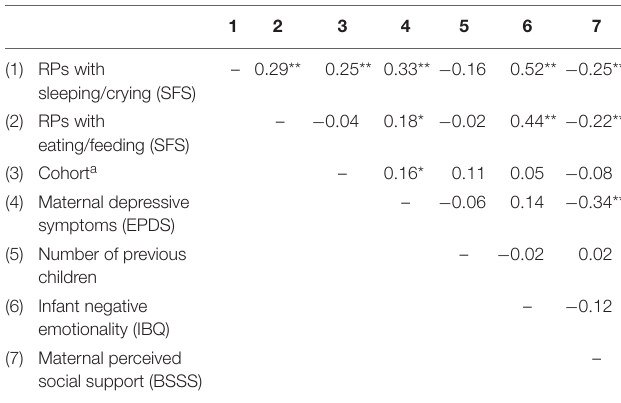
TABLE 3 | Bivariate correlations of the included